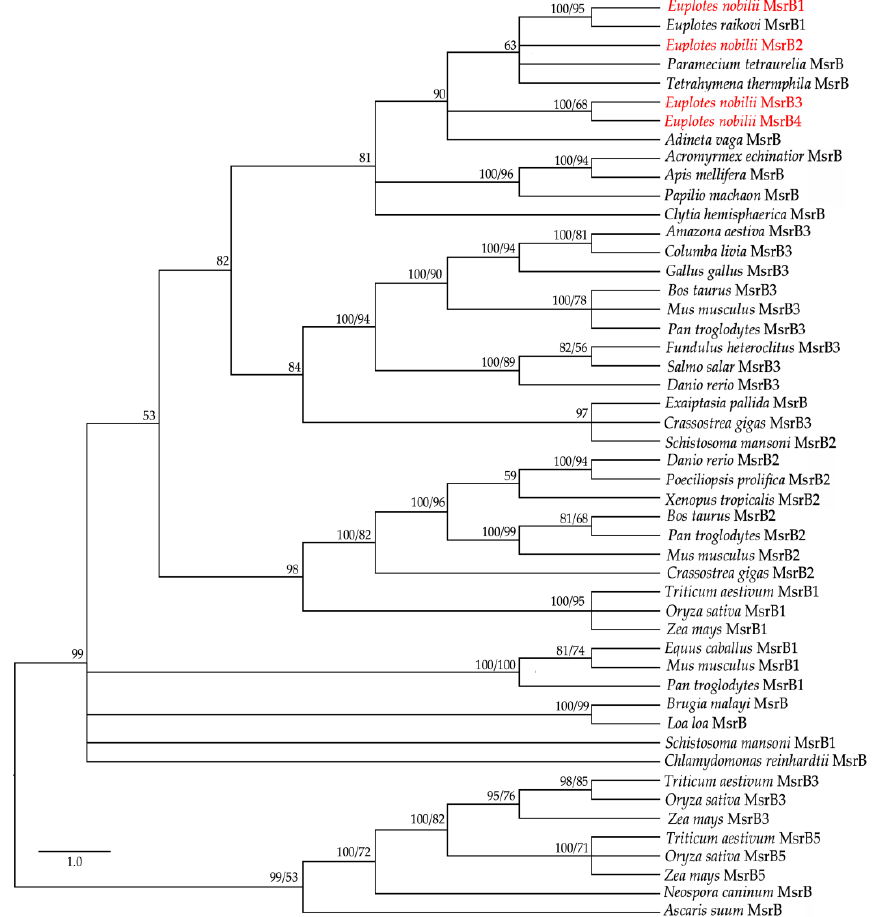
Figure 3. Phylogenetic relationships of the En-MsrB proteins (in red) with MsrBs from other organisms. Tree reconstruction based on both BI and ML methods. Posterior probability (first number) and boostrap values (second number, when present) are indicated at the nodes. The scale for the branch length is shown on the left.